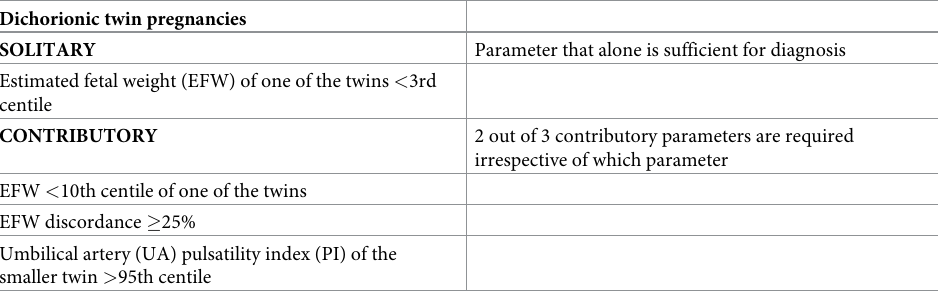
Table 1. Ultrasound criteria for the definition of FGR in dichorionic twin pregnancies (adapted from Khalil et al, 2019